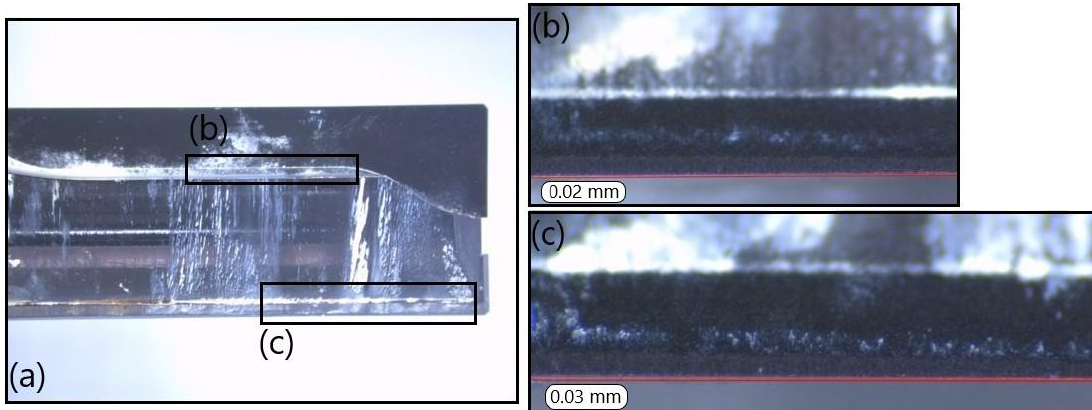
Figure 22. T3: Lateral view at the worn state: ( a ) global view of the end-mill, ( b ) zoom on the clearance face of the first cutting edge and ( c ) zoom on the clearance face of the second cutting edge.